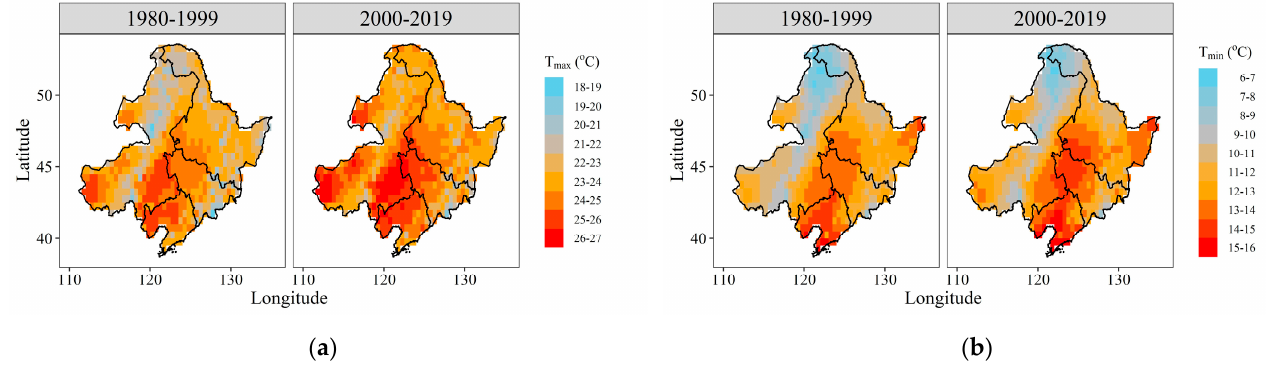
Figure A1. Change of maximum temperature (T max , ( a )) and minimum temperature (T min , ( b )) during frost-free stage in the Northeast China Plain from 1980 to 2019.